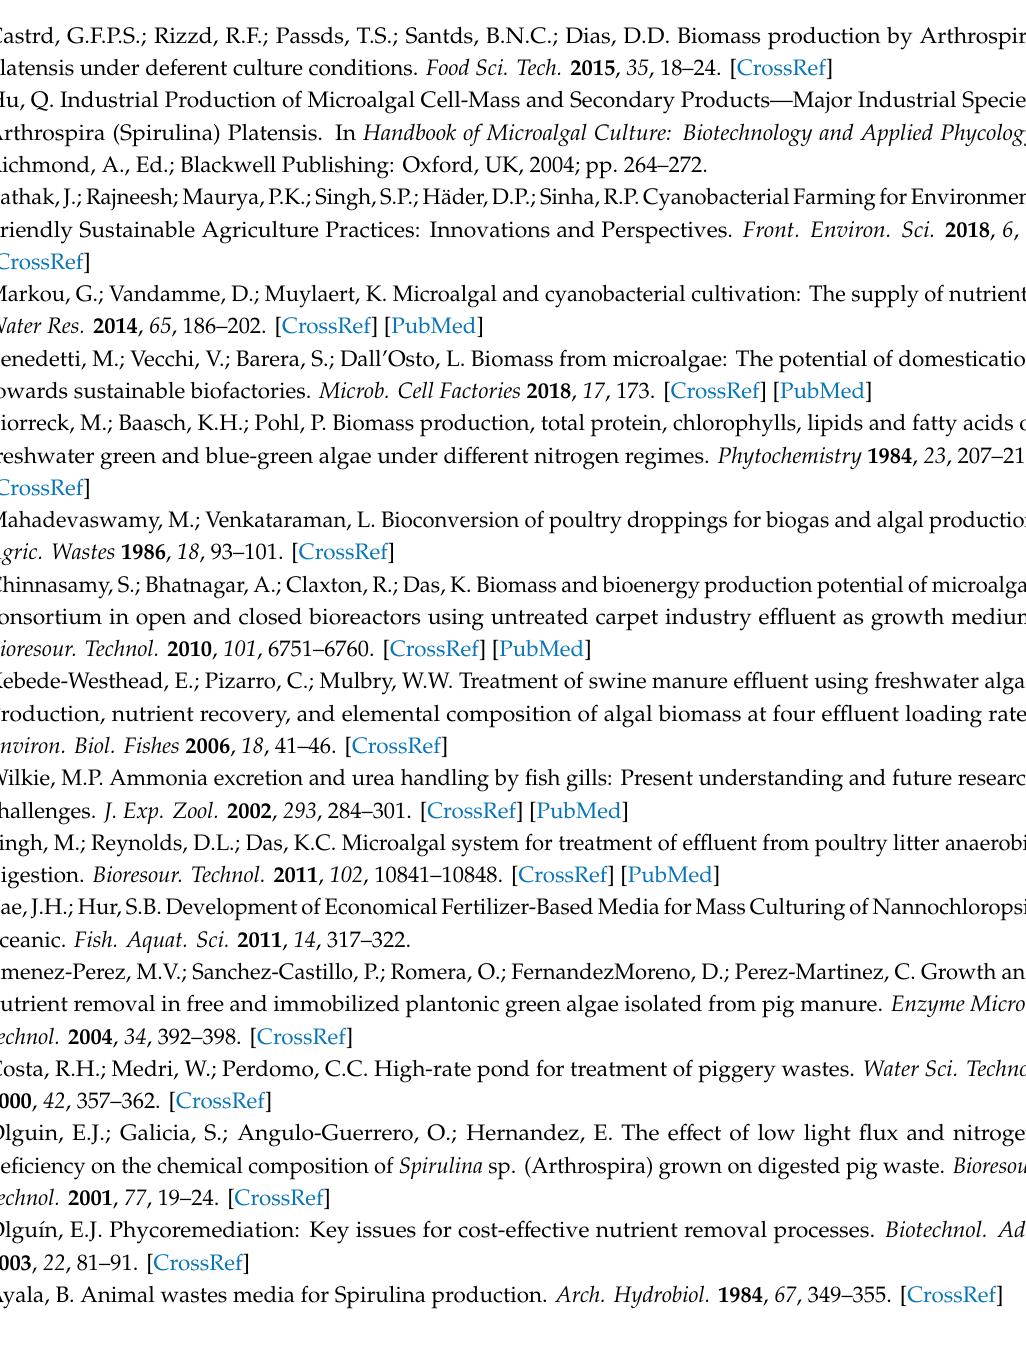
Figure S1: HSaC cyanobacterial carotenoid content as influenced by di ff erent NaCl salt concentration, Figure S2: The e ff ect of cow manure-seawater growth media on carotenoid content of salt tolerant cyanobacteria (HSaC), Figure S3: Chlorophyll content of salt sensitive cyanobacteria (LC) under seawater-cow manure growth